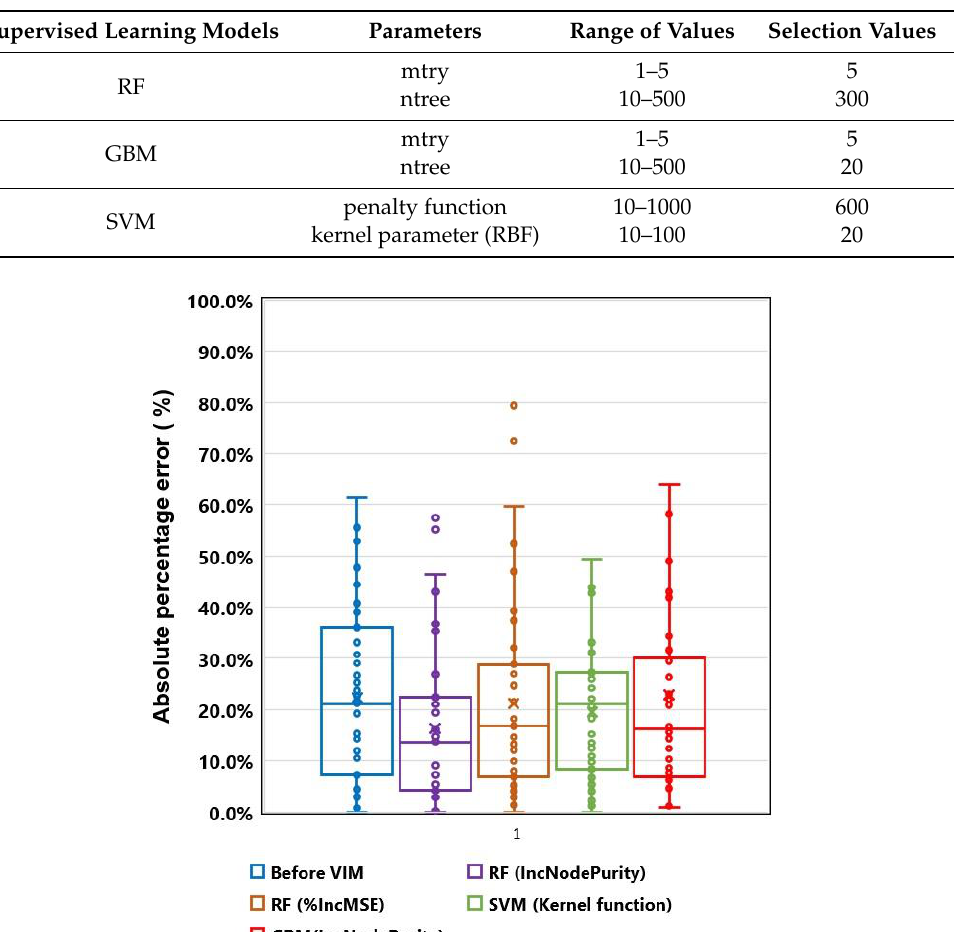
Table 3. Parameters for supervised learning models.